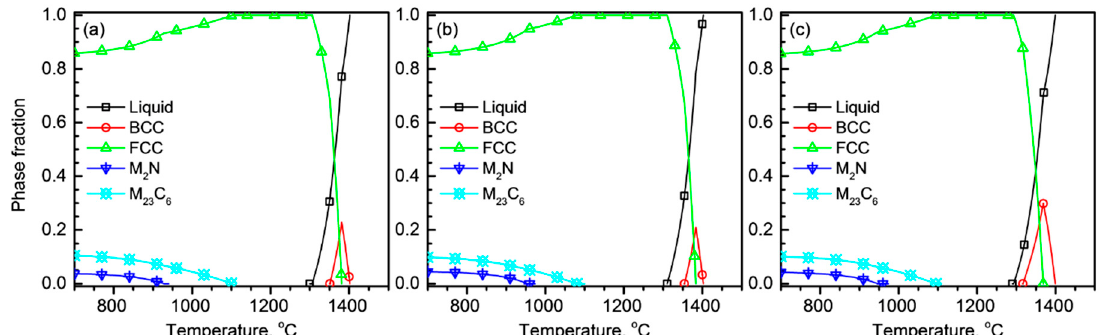
Figure 1. Phase fractions of ( a ) 0Mo, ( b ) 1Mo, and ( c ) 2Mo alloys as a function of temperature calculated using Thermo-Calc software.